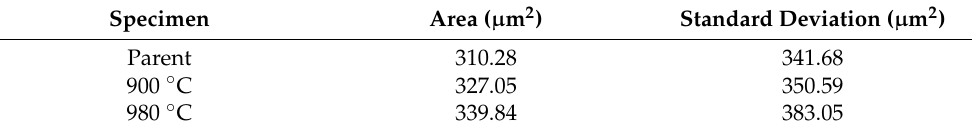
Table 6. Grain area and standard deviation for the three heat